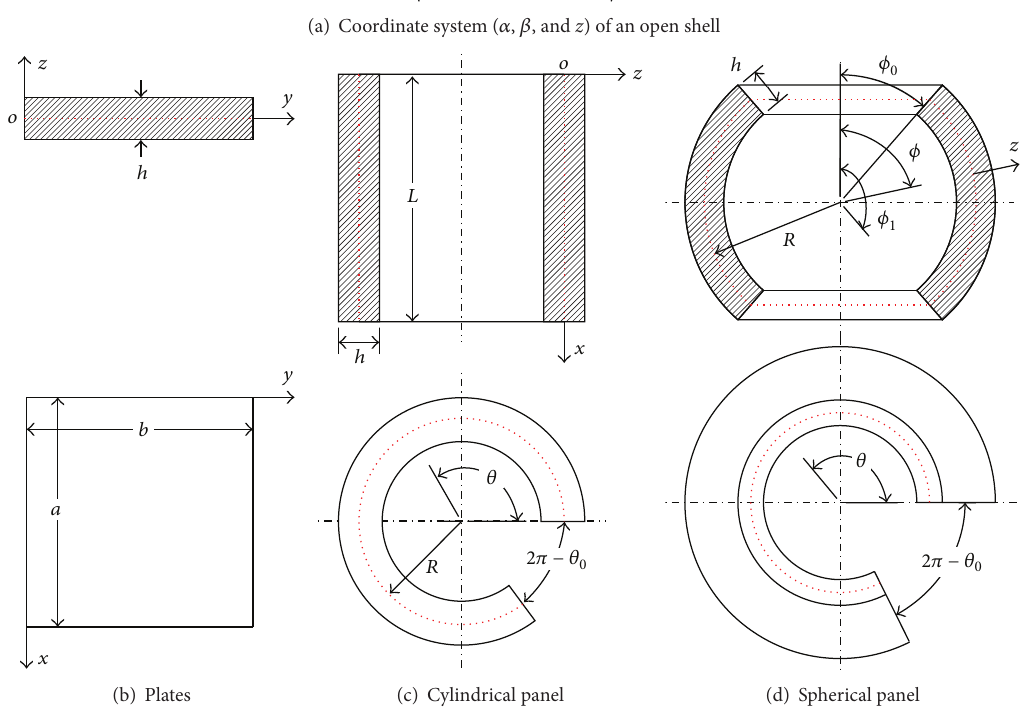
Figure 1: Geometries and coordinate systems of plates and open cylindrical and spherical